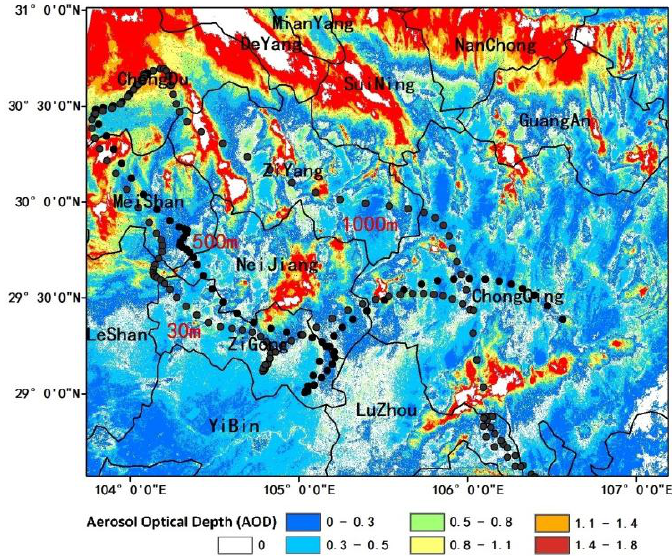
Figure 3. Aerosol optical depth (AOD) in the Sichuan Basin and backward trajectories of air mass transport over Chengdu (30,500 and 1000 m). Note: the AOD data originated from the data acquired by the HJ-1 satellite on 7 May 2014.